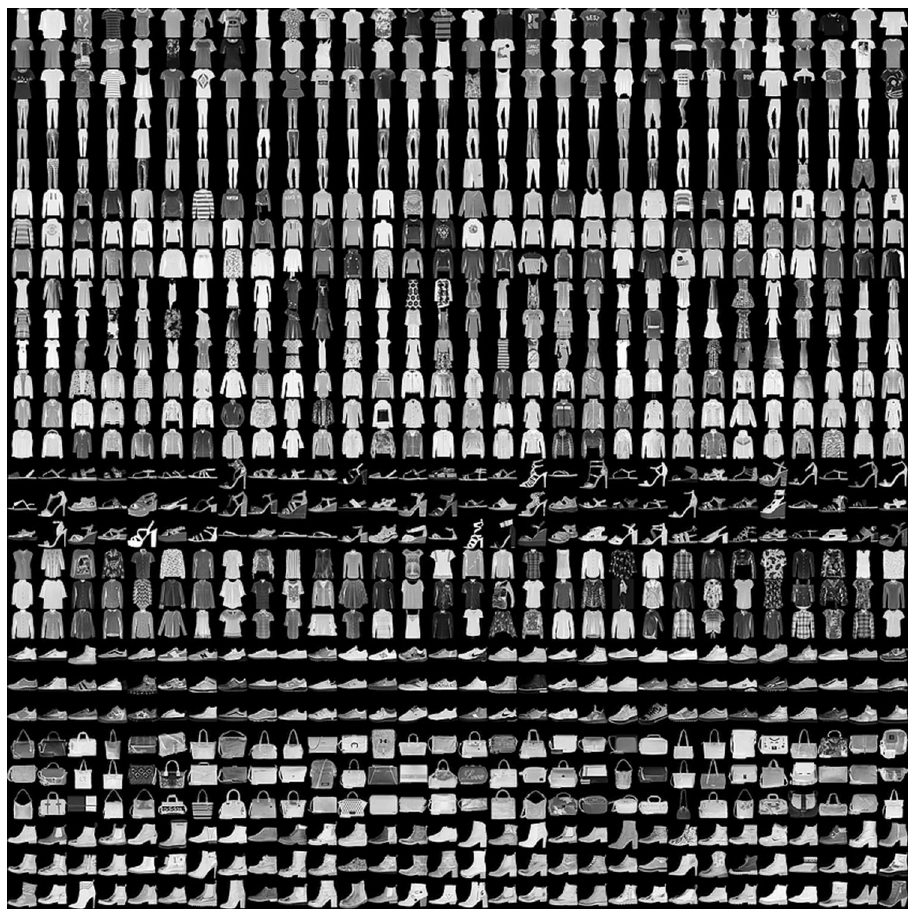
Fig. 4 Fashion MNIST sample images